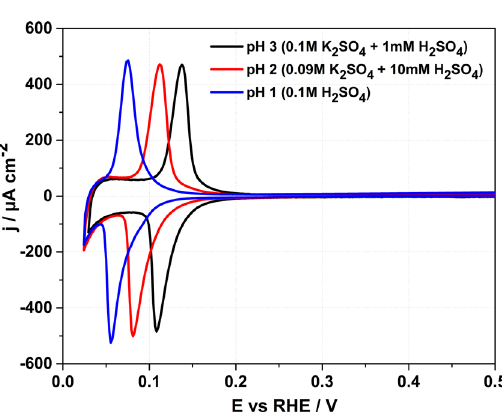
Figure 3. Typical voltammetric profiles for the Ir(111) electrodes in 0.1 M H 2 SO 4 (pH = 1), 0.09 M K 2 SO 4 + 10 mM H 2 SO 4 (pH = 2), and 0.1 M K 2 SO 4 + 1 mM H 2 SO 4 (pH = 3). Scan rate: 50 mV/s (Ar-saturated